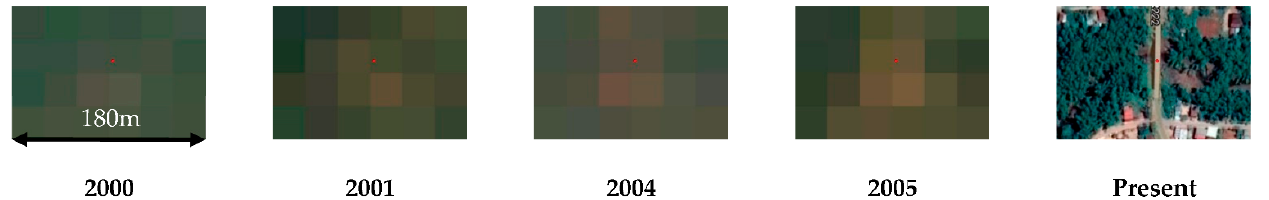
Figure 5. Yearly Landsat images of the Prek Kork bridge (L = 72 m). Year of construction of this medium length bridge cannot be judged because of the poor image resolution.